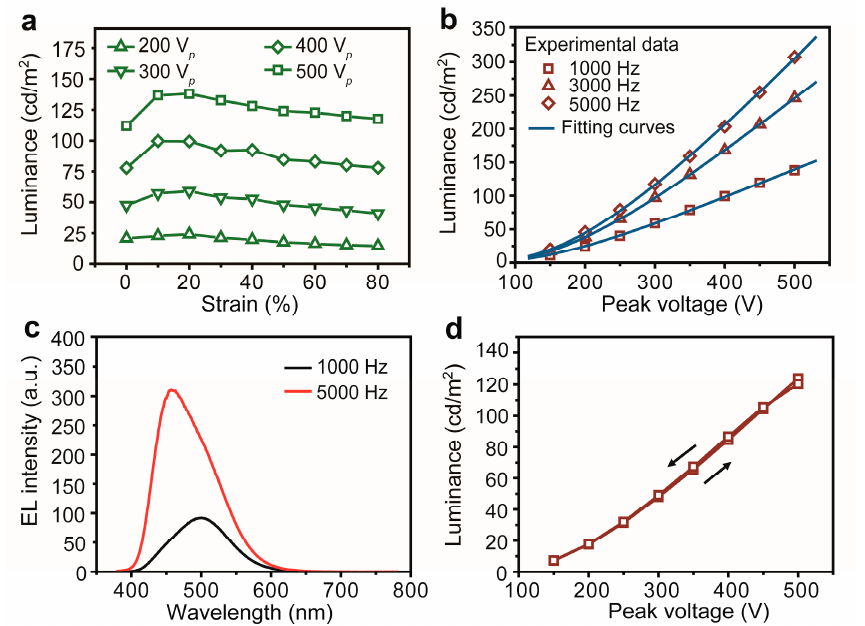
Figure 3. ( a ) Luminance–strain characteristics of the stretchable ACEL fiber under different voltages (1 kHz AC frequency); ( b ) luminance–voltage fitting curves of the stretchable ACEL fiber at 1–5 Hz and 20% strain from experimental data and theoretical calculation; ( c ) electroluminescent spectra of the stretchable ACEL fiber at 1 kHz and 5 kHz AC frequencies; and ( d ) the luminance-voltage hysteresis characteristics of the stretchable ACEL fiber at 50% strain (1 kHz AC frequency).